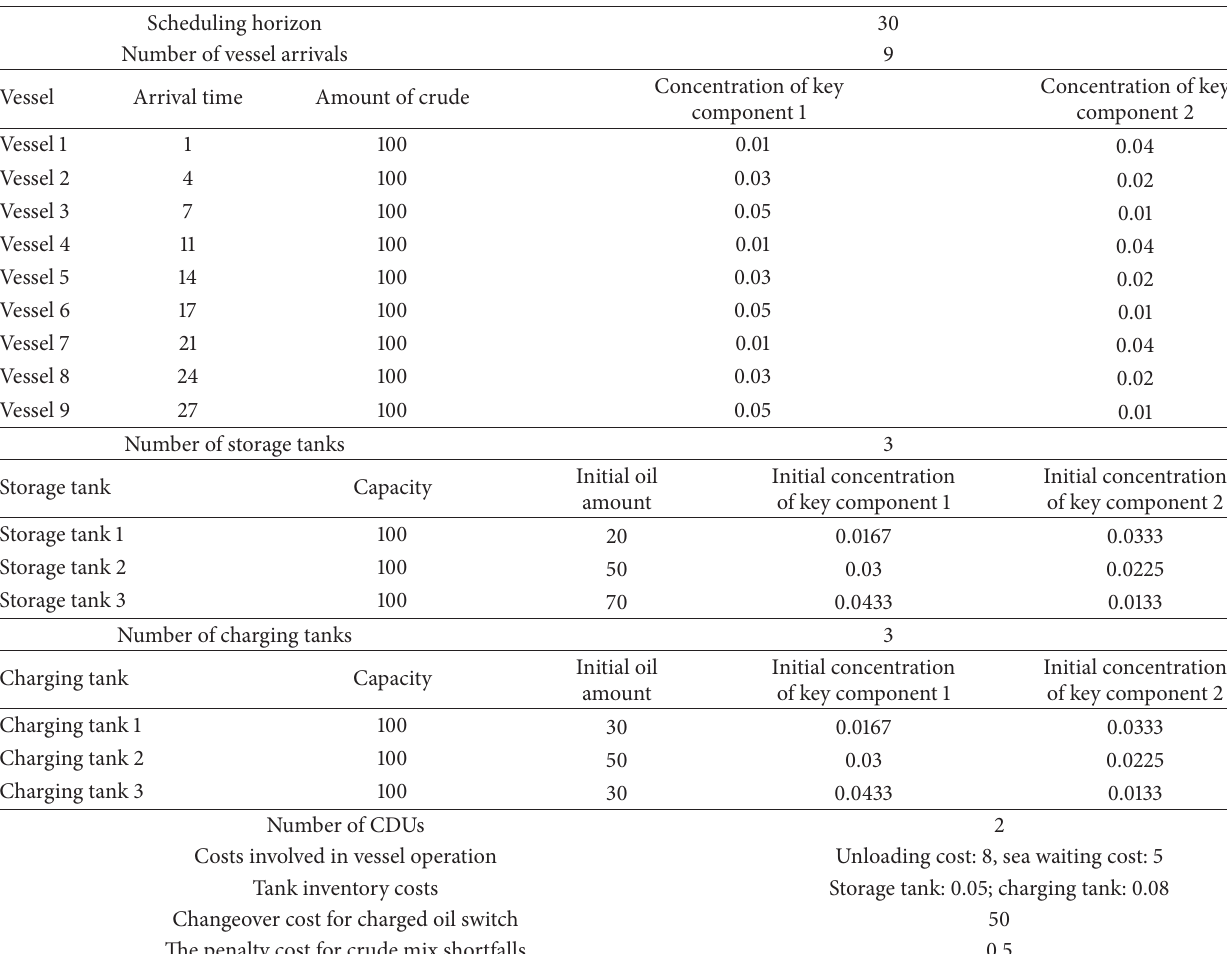
Table 1: System information.